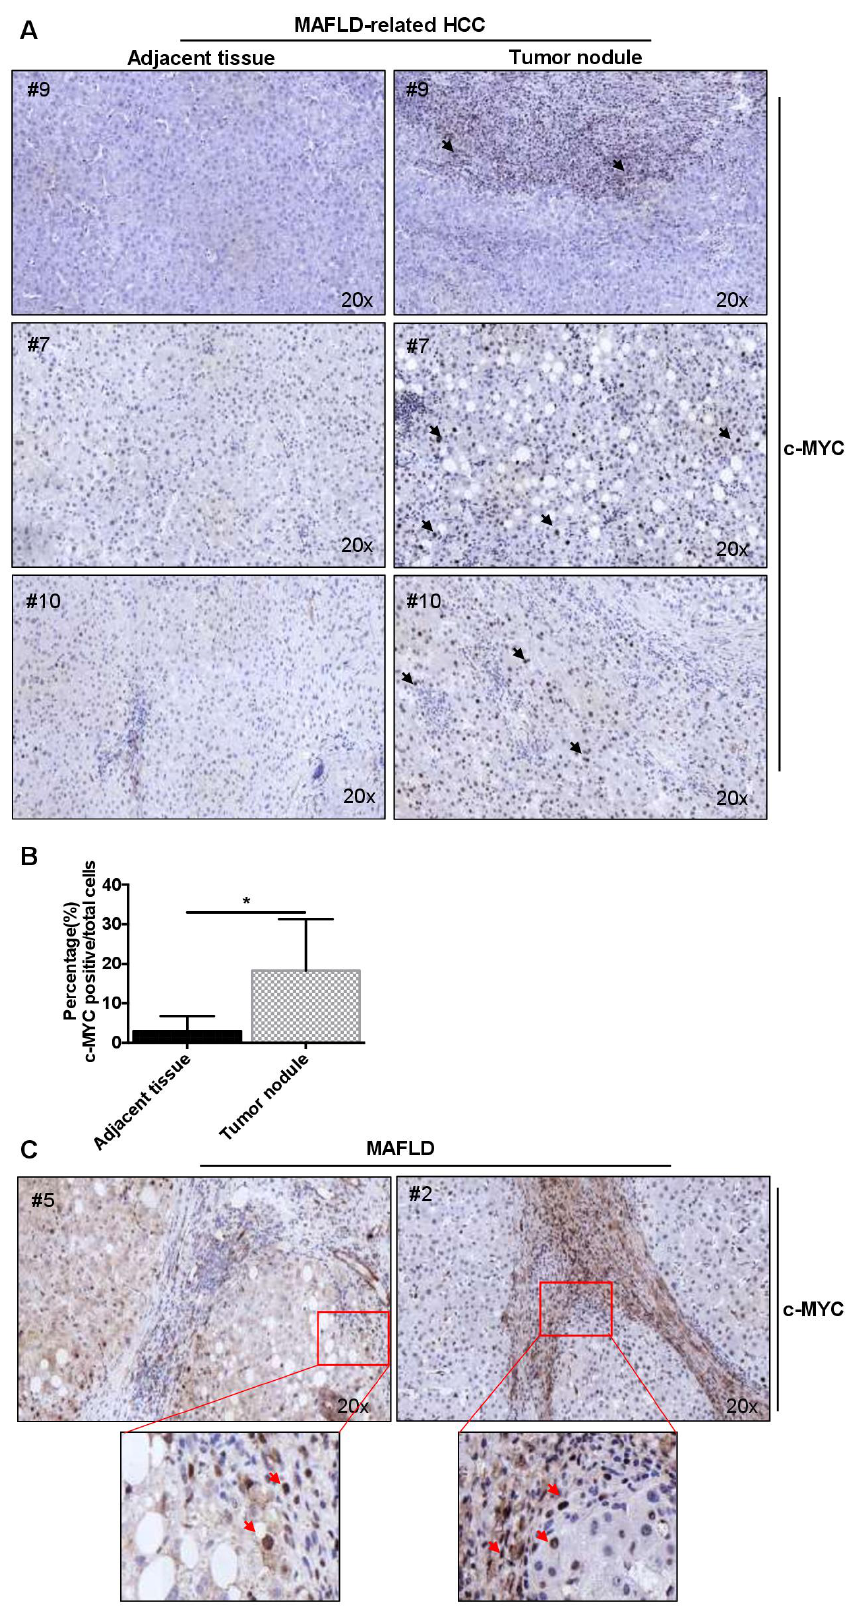
Figure 1. High expression of c-MYC in patients with MAFLD and MAFLD-related HCC. ( A ) c-MYC nuclear expression inside tumor nodules and tumor-adjacent tissues in patients with MAFLD-related HCC (20 × magnification). Black arrows indicate cells with positive nuclear c-MYC expression